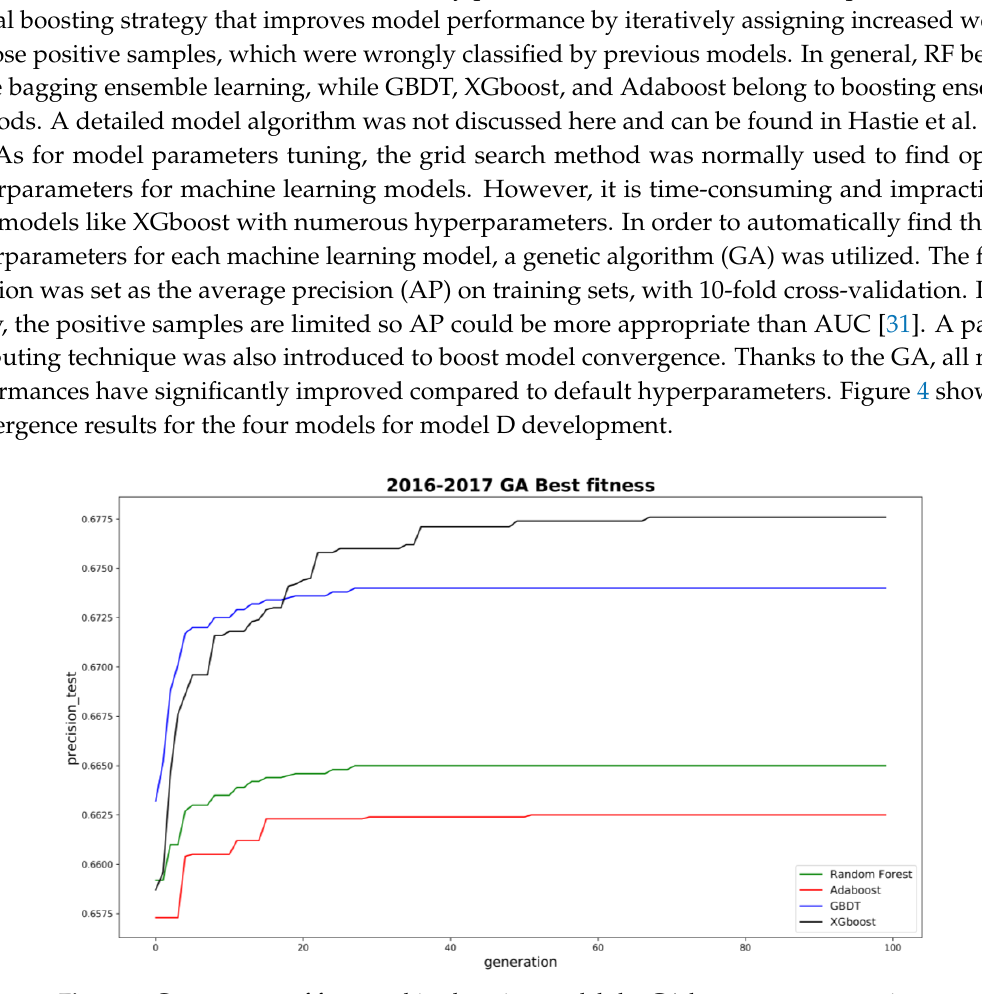
Figure 4. Convergence of four machine learning models by GA hyperparameter tuning.